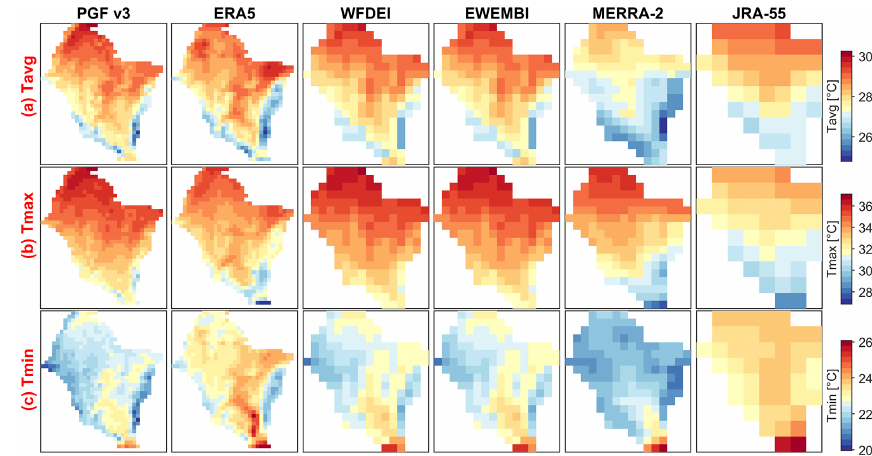
Figure A2. Mean annual air temperature (average a , maximum b and minimum c ) over the period 2003–2012 for six temperature datasets in the Volta River